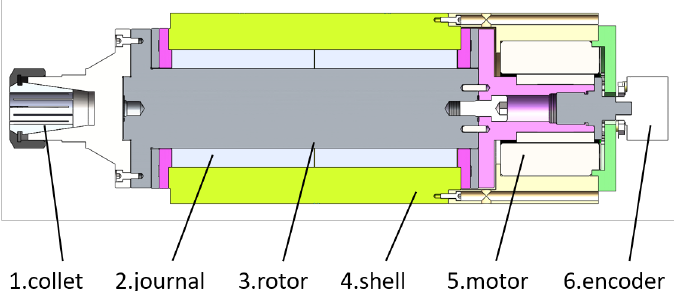
Figure 1. Aerostatic motorized spindle.